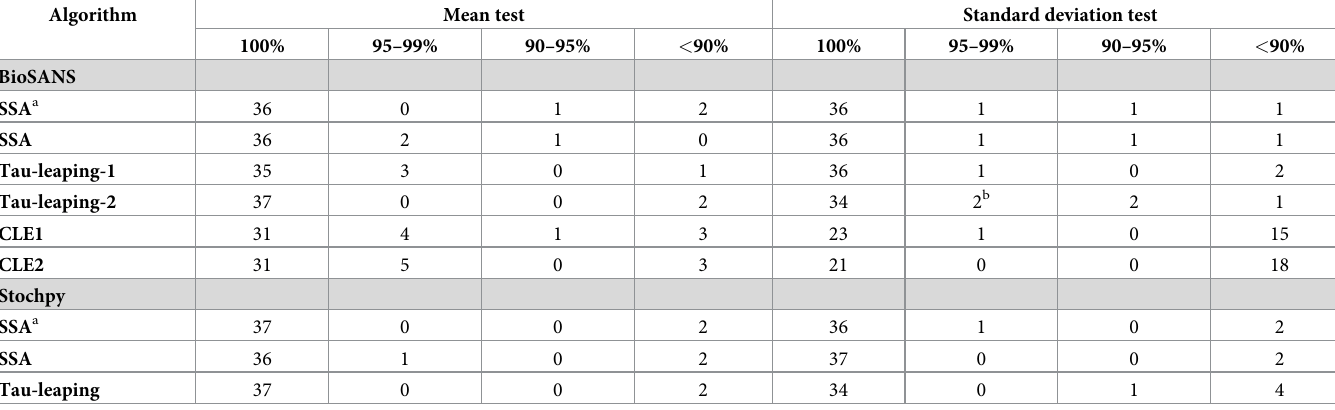
a —Shown are number of test cases with their corresponding number of cases passed for a percentage range among 39 cases using the exact test. All others were tested by using the inexact test.